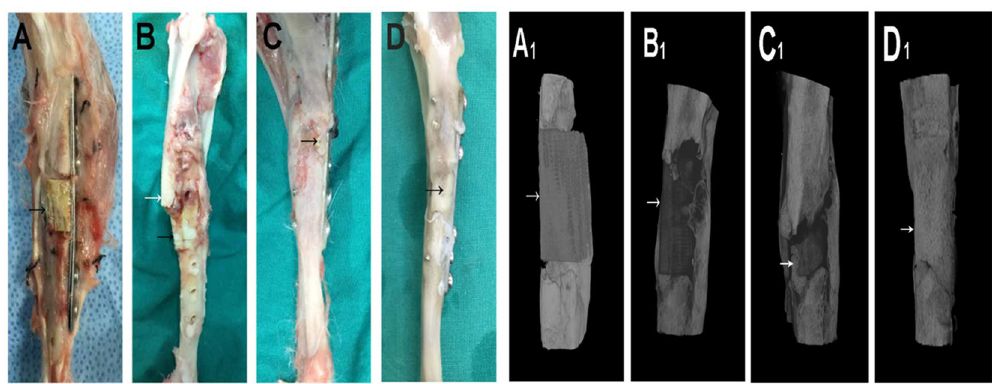
Figure 10. Gross appearance and CT reconstruction images of control ( A , A 1 ), B ( B , B 1 ), BV ( C , C 1 ) groups and autogenous bone ( D , D 1 ) for 12 weeks, arrows indicate the bone